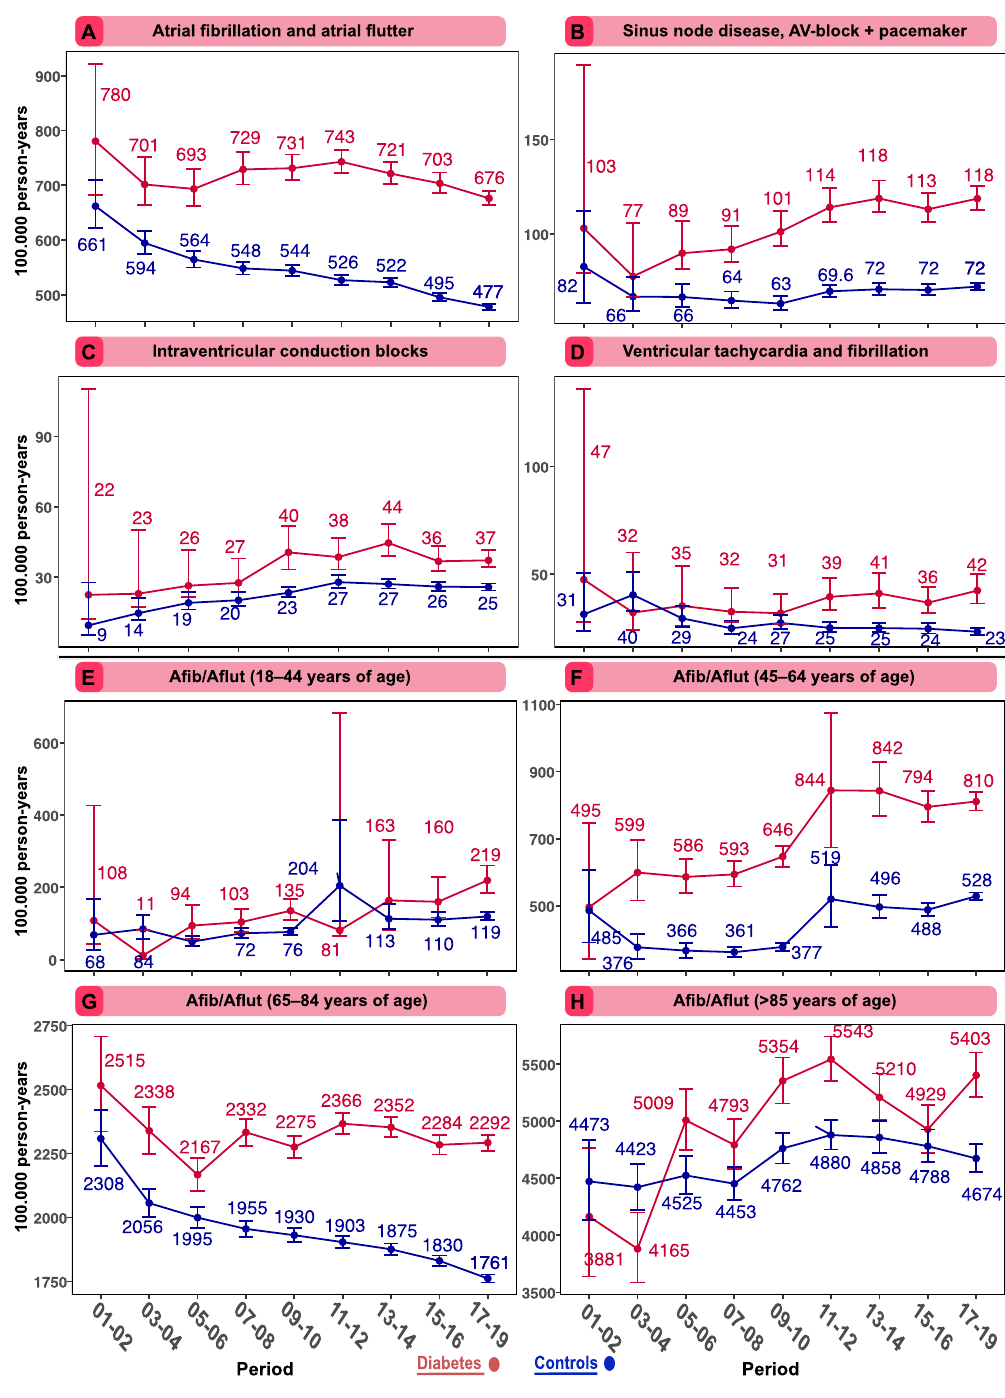
Figure 1. Standardized incidence rates for cardiac arrhythmias among patients with type 2 diabetes, as well as, matched controls from general population, per 10. Panel E–H display atrial fibrillation and flutter among various age-categories. The dark lines indicate the hazard function and the shaded areas 95% confidence